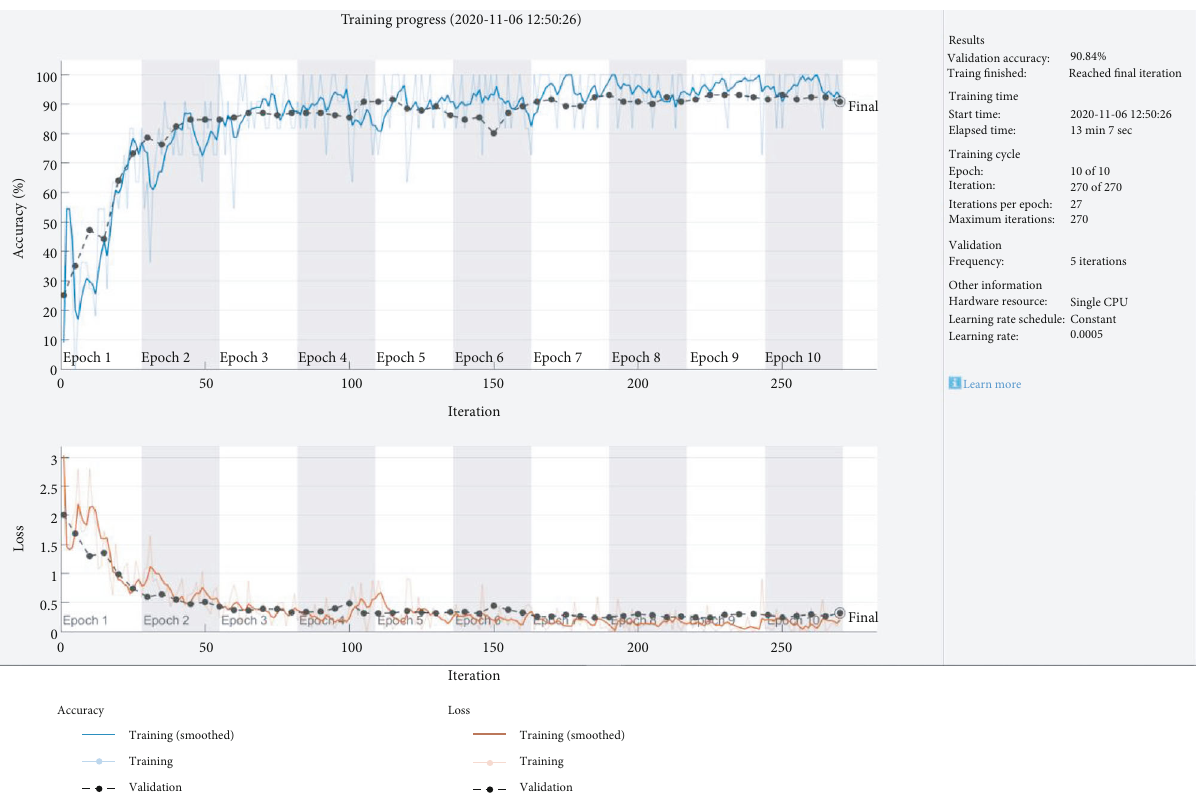
Figure 4: E ff ect of GoogLeNet network on clear image